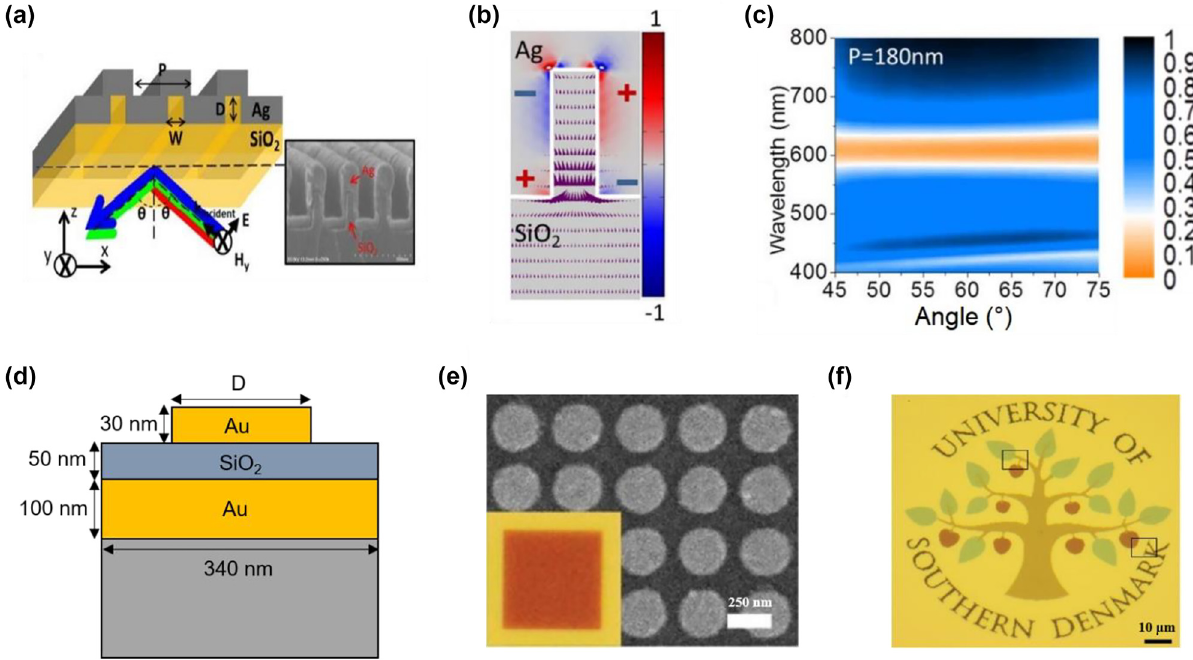
Figure 12: Plasmon resonance for angle-insensitive structural color generation. (a) Schematic diagram of a metallic nanoslit-based angle-insensitive structural color device, where an optically-opaque Ag layer is conformally coated on a 1D subwavelength-pitch fused silica grating layer. The associated SEM image of a fabricated device is displayed in the inset. (b) Polarization charge and Poynting vector distribution of light funneled into a nano-slit, represented by the red–blue surface plot and purple arrows, respectively. (c) The angularly-resolved reflection spectra of a device under TM polarized illumination (magnetic field oscillating along the grating direction). The period, width, and height of the grating are respectively chosen as 180 nm, 50 nm, and 130 nm. The device exhibits almost-identical subtractive colors as the angle of incidence varies. Modified with permission [145]. Copyright 2013, Nature Publishing Group. (d) Schematic illustration of a metal-insulator-metal (MIM) configuration for angle-insensitive structural layer in between. (e) SEM image of a fabricated color generation. The unit cell consists of a circular Au nanodisk, a continuous Au layer, and a SiO 2 sample consisting of arrays of 270 nm-diameter Au nanodisks. Inset is the associated optical photo. (f) A colored logo of the University of Southern Denmark, created using the designed MIM plasmonic structures. Modified with permission [153]. Copyright 2014, American Chemical